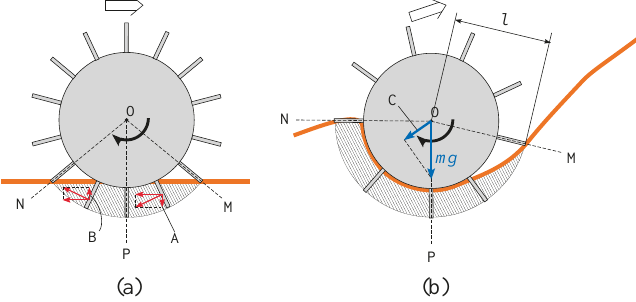
Figure 1. Conventional rover wheel: ( a ) On a level incline; ( b ) On a steep incline.